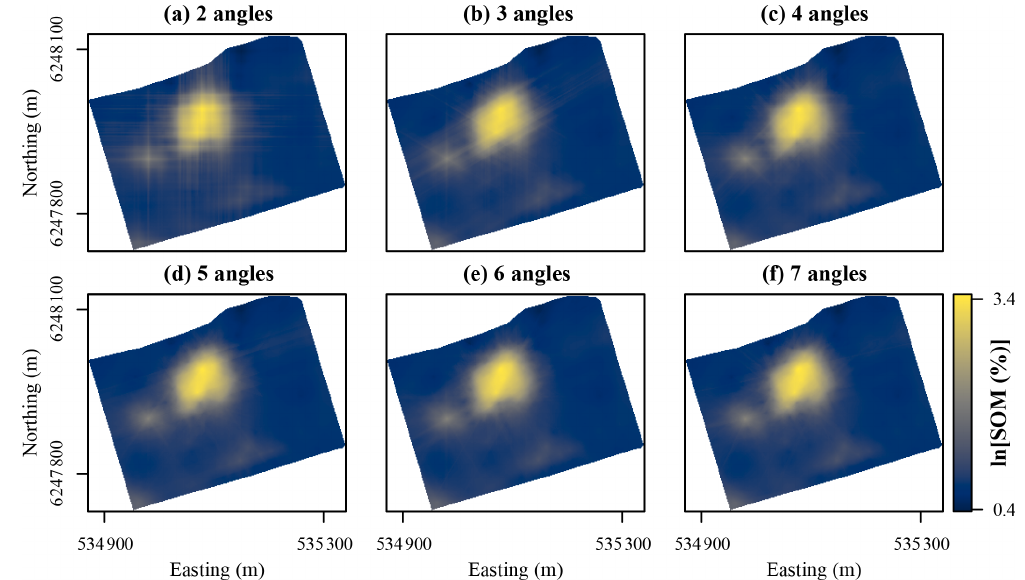
Figure 5. Maps of soil organic matter (SOM) contents in the topsoil at Vindum predicted using random forest models trained with coordinate rasters at two to seven different angles as covariates. Easting and northing for UTM zone 32N